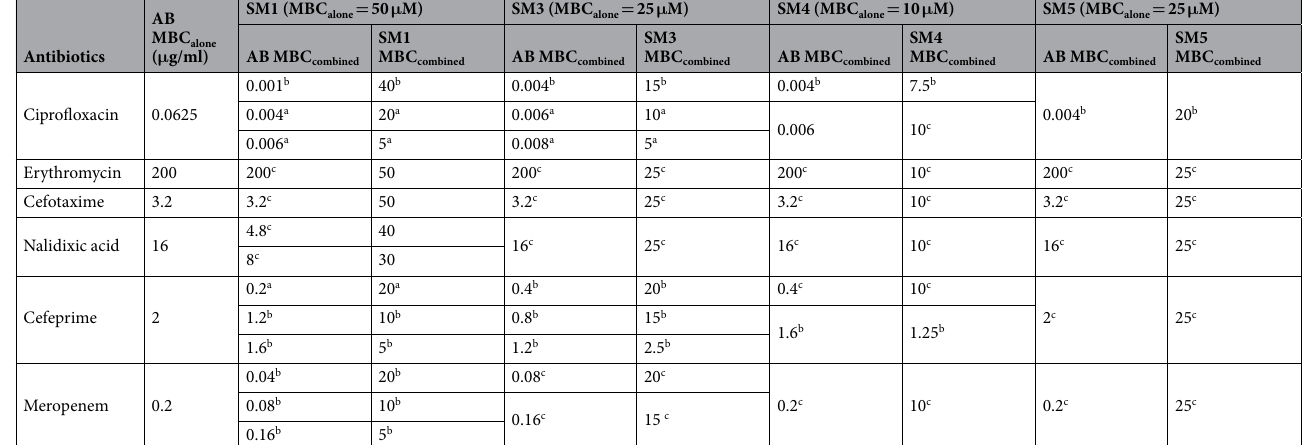
Table 2. Combination effects of small molecules (SMs) and antibiotics on Salmonella enterica subsp. enterica serotype Typhimurium. a Synergetic effect (FBC ≤ 0.5; reduction in MBCs superior to 75% for both antibiotic and SM). b Additive effect (FBC > 0.5 and ≤ 1.0; percentage reduction in MBCs between 50% and 75% for both antibiotic and SM). c Indifferent (FBC > 1.0 and ≤ 2.0; reduction in MBCs inferior to 50% for both antibiotic and SM). Antibiotic values in μ g/ml. SM values in μ M. MBC: minimal bactericidal concentration; AB: antibiotic; FBC: fractional bactericidal